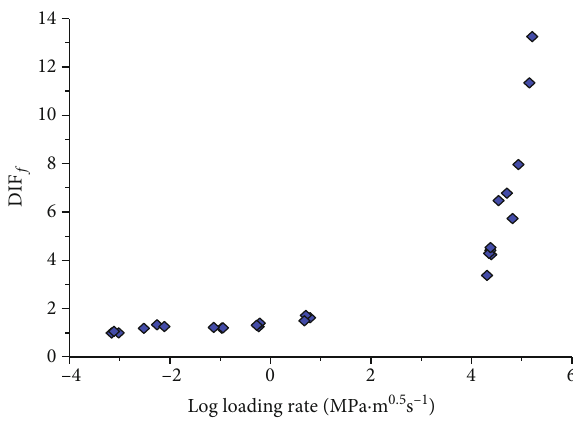
Figure 7: Comparison of the fi tting formula and measured